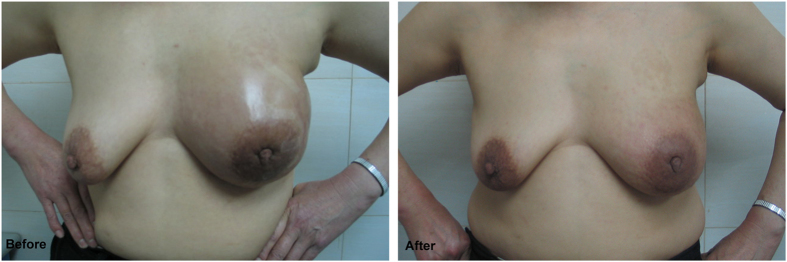
Before: Inflammatory breast cancer. The edema of left breast and surrounding skin were obvious, which made radical surgery impossible. After: The edema of breast subsided after 6 cycles of primary TE chemotherapy, which met the radical surgery standard.